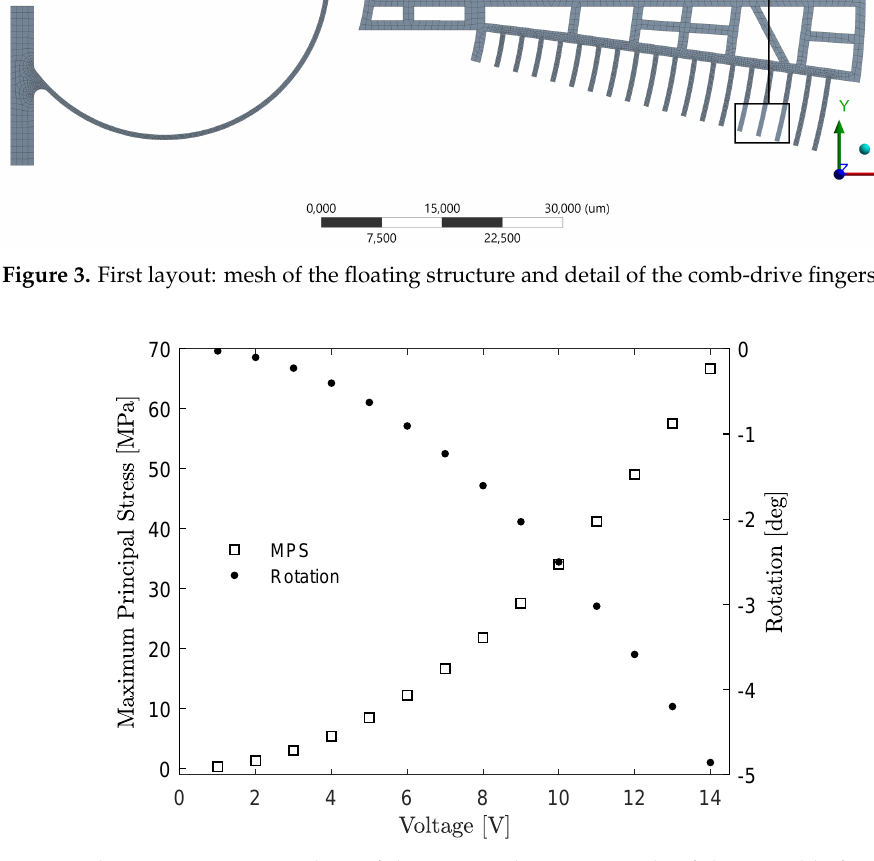
Figure 4. First layout: maximum values of the MPS and rotation angle of the movable fingers for increasing values of the applied voltage